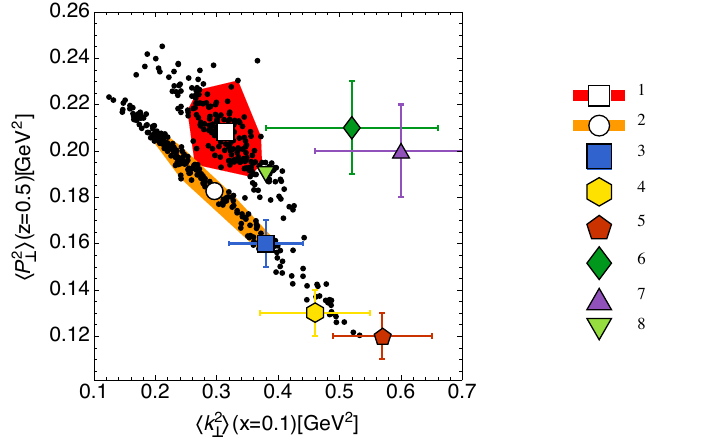
Figure 9 . Correlation between transverse momenta in TMD FFs, PDFs, k 2 ( x = 0 : 1) , in different phenomenological extractions. (1): average values (white square) ? i h obtained in the present analysis, values obtained from each replica (black dots) and 68% C.L. area (red); (2) results from ref. [23], (3) results from ref. [97], (4) results from ref. [76] for Hermes